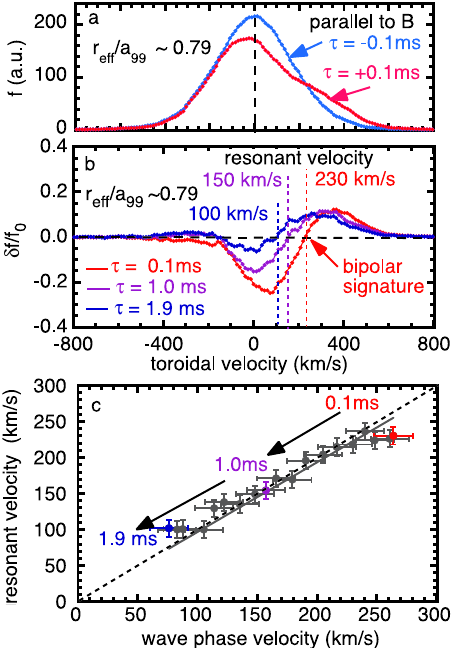
Fig. 3 Resonant velocity of Landau damping. a Distribution function of ion velocity at r eff / a 99 = 0.79 and at 0.1ms before (blue circles) and after (red circles) the onset of MHD (magnetohydrodynamics) burst, b the difference of velocity distribution function between 0.1ms before and 0.1 ms (red circles), 1.0ms (purple circles), 1.9ms (dark blue circles) after the onset of MHD burst. c relation between the phase velocity of wave evaluated from the frequency of plasma displacement plotted in Fig. 2e. The error bars of resonant velocity and wave phase velocity are uncertainties attributed to an evaluation of zero-cross velocity of bipolar signature and peak frequency of plasma displacement, respectively. (#164992,